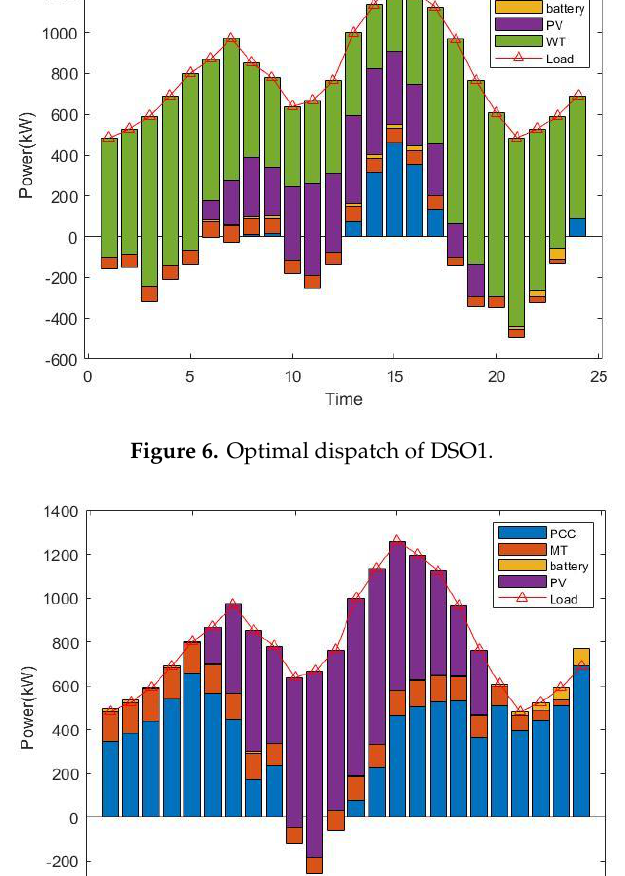
Figure 5. Optimal dispatch of VMG2.